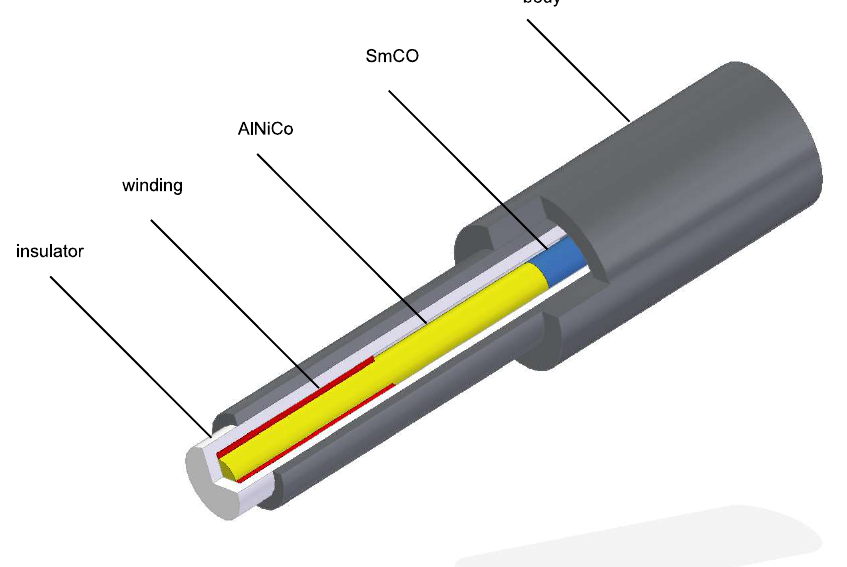
Figure 5. Two magnets and winding inside the